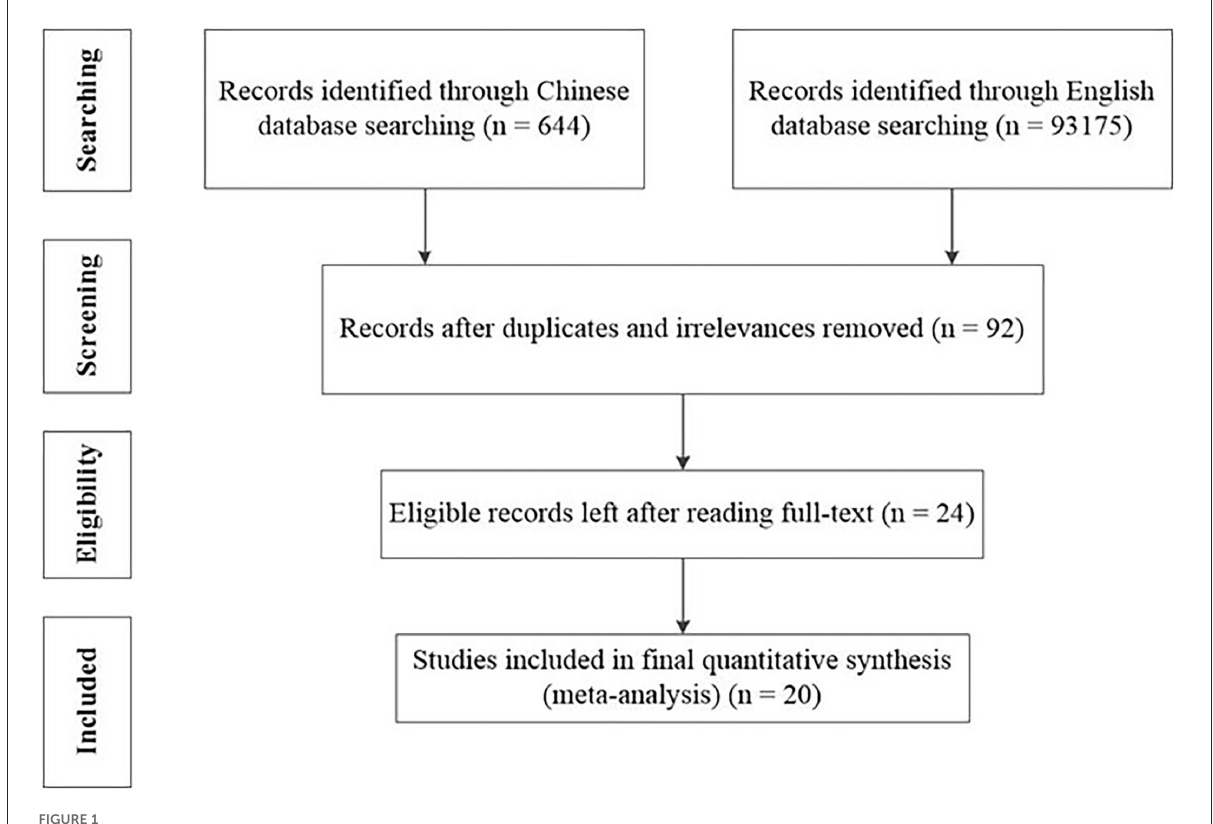
FIGURE1 Chart of the study selection